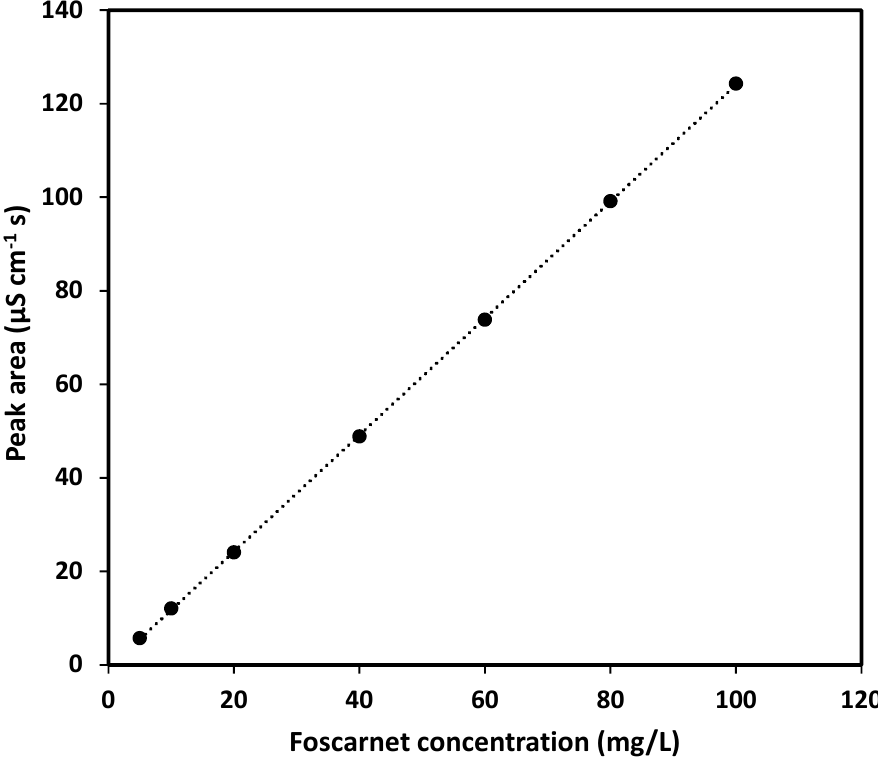
Figure 5. Calibration line for foscarnet prepared at seven concentration levels from 5 to 100 mg/L.